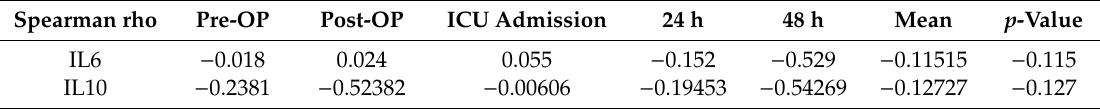
Figure 5. Association of perioperative vitamin C levels with interleukin 6 (IL6) ( A , B ) and interleukin 10 (IL10) ( C , D ). N, number of patients; ( A , C ), patients with preoperative vitamin C deficit; ( B , D ), patients with intraoperative loss of vitamin C ≥ 50%. Circles represent outliers. Table 3. Correlation between vitamin C and interleukin 6 (IL6) and interleukin 10 (IL10).